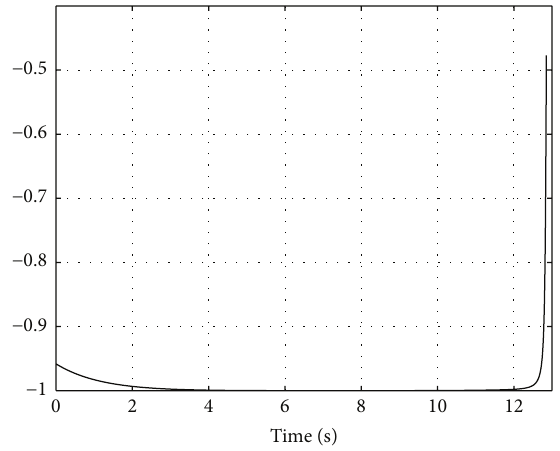
Figure 10: Variation of 𝑍